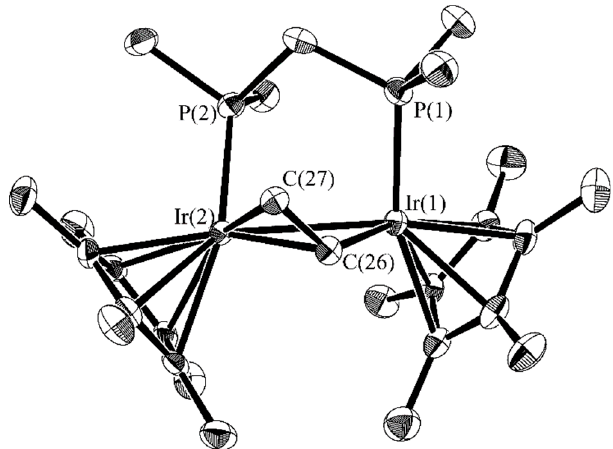
Figure 4. ORTEP drawing of the cationic part of 5 . Hydrogen atoms are omitted for clarity.